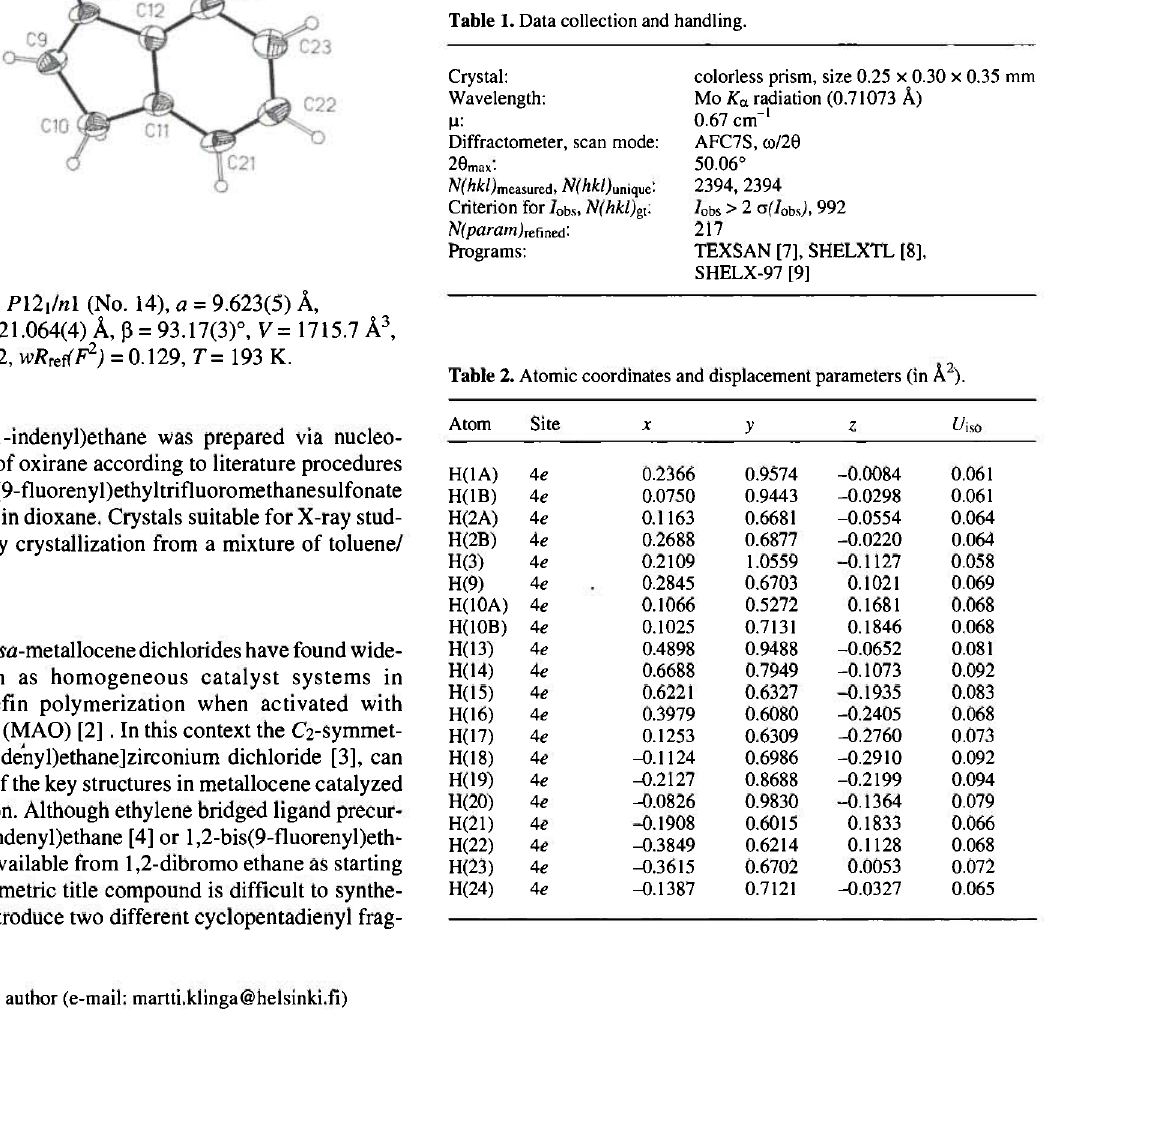
Table 1. Data collection and handling.